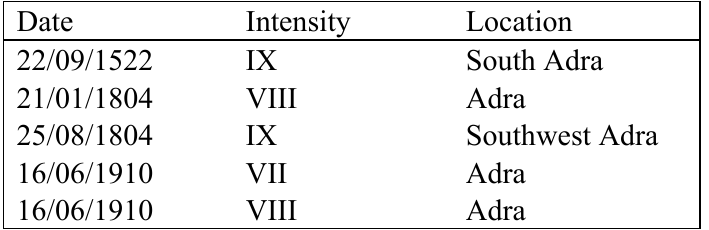
Table 1. Historical seismicity near Balanegra Fault (from [16]).